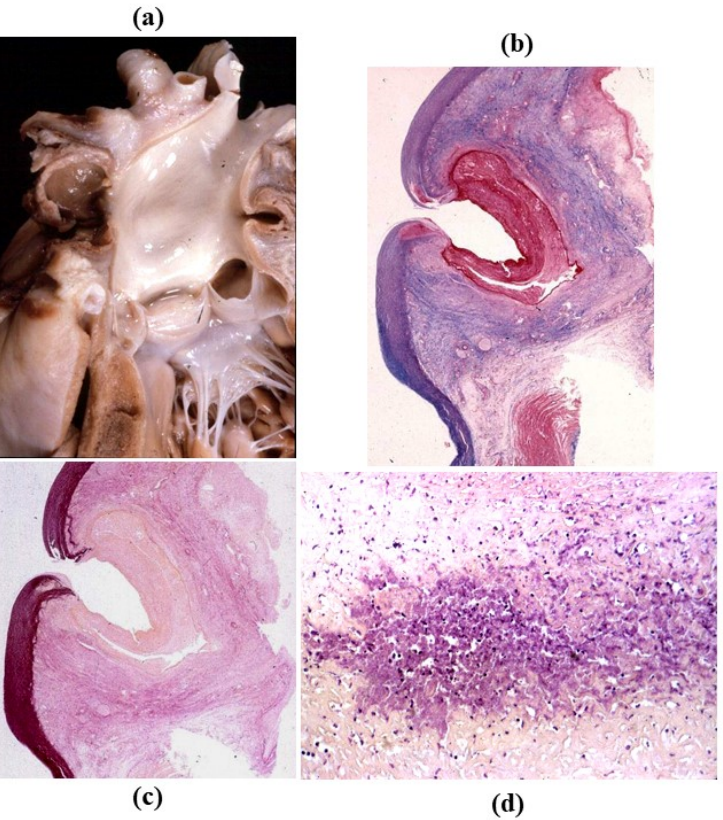
Figure 24. Mycotic aneurysm of the ascending aorta. ( a ) Gross appearance. ( b ) Histology: through and through laceration of the aortic wall with false aneurysm (Alcian PAS stain). ( c ) Same as ( b ) (Weigert Van Gieson stain). ( d ) Abscess by cocci in the aortic wall (hematoxylin-eosin stain).